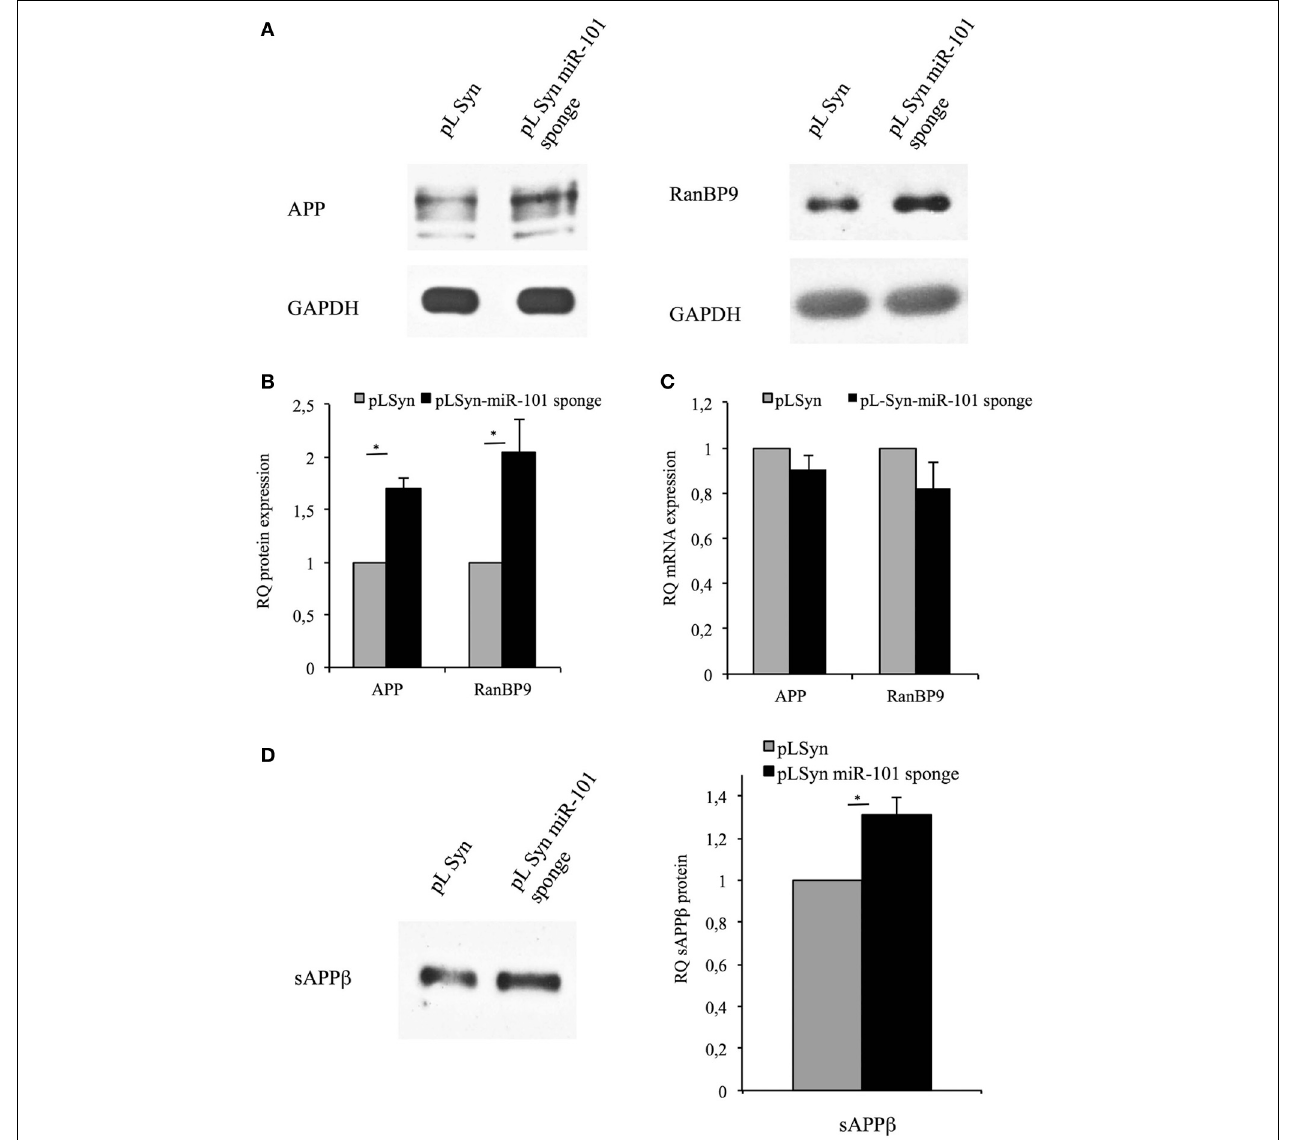
FIGURE 3 | Inhibition of miR-101 in neurons increases levels of endogenous RanBP9, full-length APP, and its secreted product, sAPP β . (A) Representative Western blot analysis of protein extracts from lentiviral vector-transduced hippocampal neurons at 7 days post-infection with an antibody recognizing RanBP9, an antibody recognizing full-length APP (4G8), or an antibody recognizing GAPDH. Full blot for RanBP9 with multiple samples is shown in Figure S1 . (B) The intensities of the bands were quantified by densitometry. The results obtained with the 4G8 antibody or the RanBP9 antibody were normalized to those obtained with the GAPDH antibody and expressed as arbitrary optical density (OD) units. The band intensities for miR-101 sponge-containing neurons were quantified relative to those for control pLSyn vector-containing neurons.